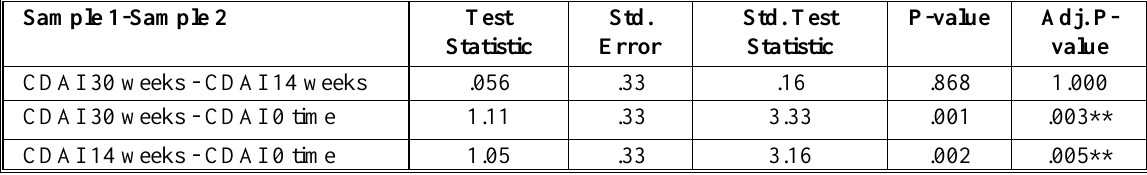
Table 5-B. Pairwise comparisons Sample 1-Sample